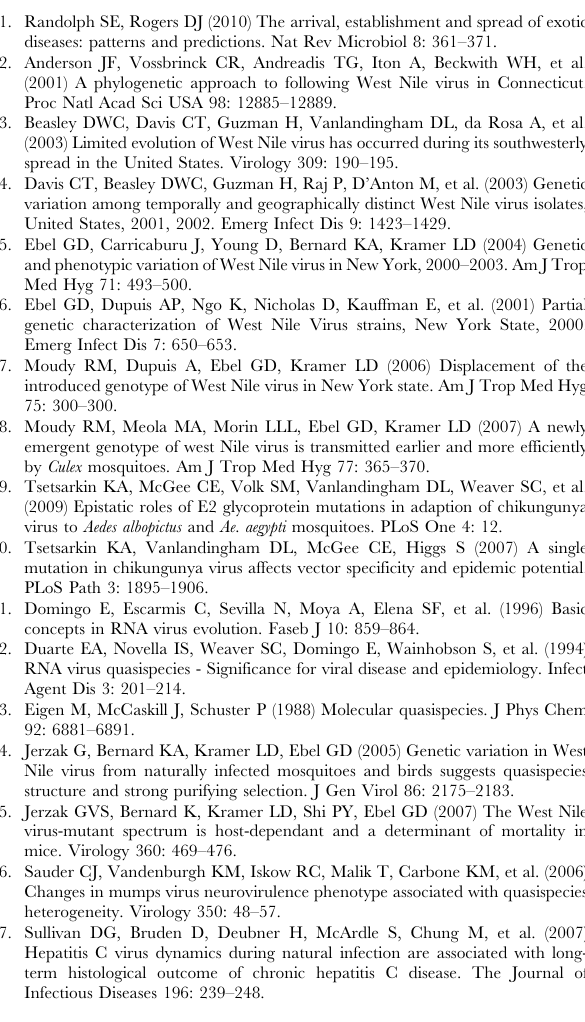
Figure S2 WNV titers in Culex pipiens quinquefasciatus hemolymph at early time points. Mosquitoes were offered a WNV Mix24 infectious bloodmeal and hemolymph extracted at multiple time points. WNV titers were determined by plaque assay. Figure S3 Bayesian trees with the most parsimonious reconstruction of tissue character states from the six remaining mosquitoes. Blue =input (i), pink = midgut (m), gold = legs (l), black= salivary secretions (s), dotted = multiple tissues, with specific tissues indicated by abbreviations. Hatched branches indicate equivocal reconstruction of character states. Numbers above the nodes are the posterior probabilities inferred for each clade. Mosquito analyzed and most parsimonious reconstruction of ordered character steps for each tree is as